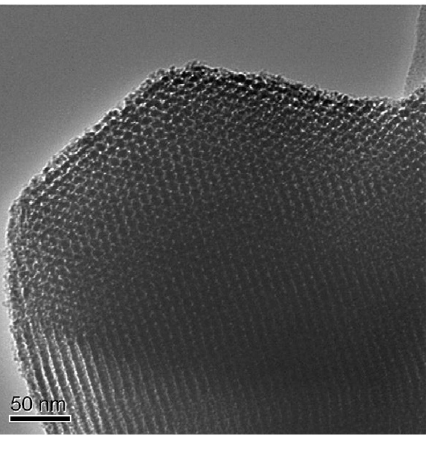
Figure 5. TEM image of SBA-15 particles (Reprinted with permission from